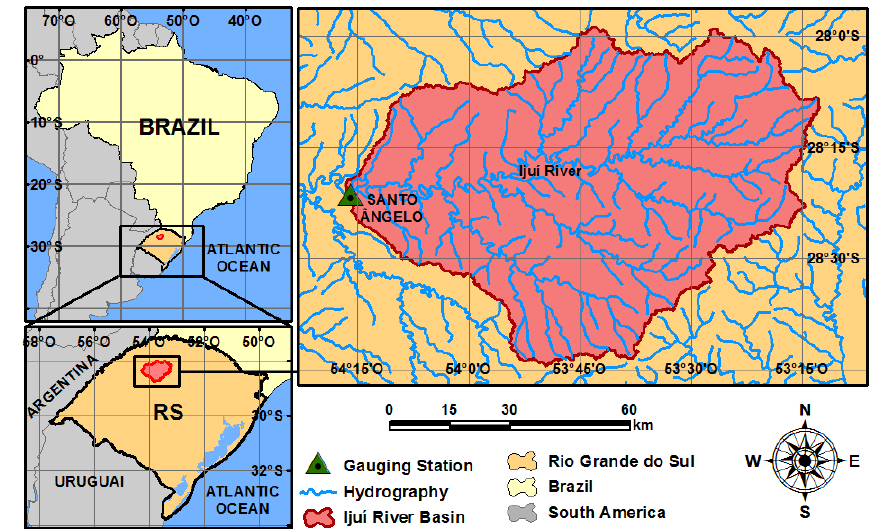
Figure 1. Location of the Ijuí River basin, section upstream from the Santo Ângelo gauging station (5414km 2 ), RS,